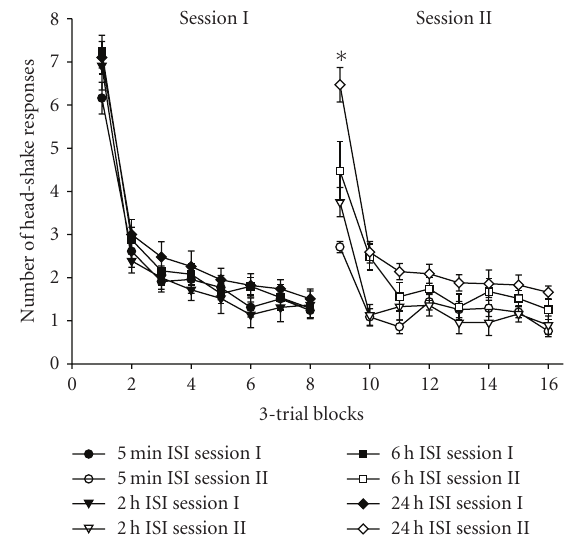
Figure 2: Mean ( ± SEM) group changes in head-shake responses (HSR) per three-trial blocks during sessions I and II. These sessions were separated by 5 minutes, 2, 6, or 24 hours, respectively. There were no di ff erences among these groups comparing the first trial blocks of Session I. Each group significantly di ff ered from the others comparing the first trail blocks of Session II. Specifically, the 5 minute ISI group indicated very little spontaneous recovery suggesting excellent memory retention of the habituatory response. The 2 and 6 hours ISI groups showed increments in spontaneous recovery and thus some loss of memory retention, while the 24- hour ISI group revealed 95% spontaneous recovery suggesting nearly complete loss of memory retention for habituation of the HSR, ∗ P < . 05, modified from Wright et al.